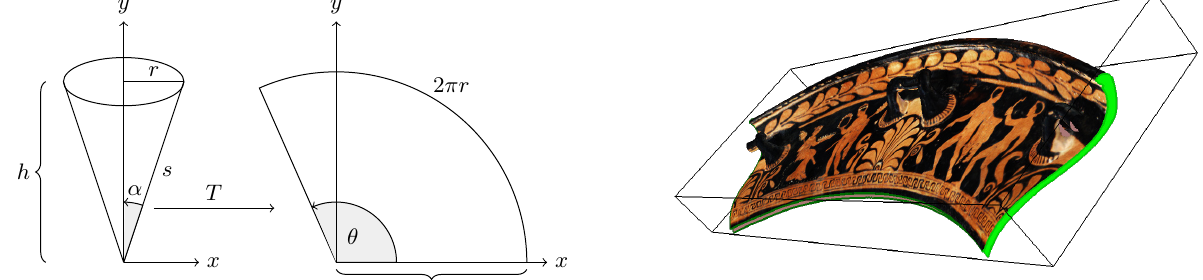
Figure 4: Depiction of the unwrapping process of a cone. Note how angles and heights of the points on the cone are changed.